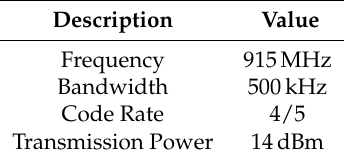
Table 2. Configuration parameters.